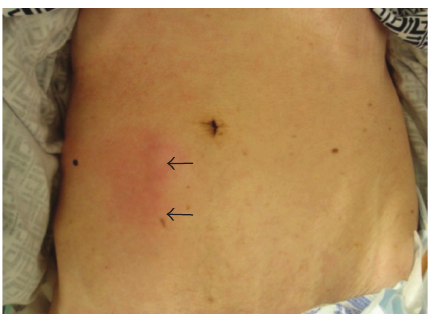
Figure 2: A photograph of the abdomen demonstrates subcuta- neous swelling in the right lower quadrant of the abdomen (see area adjacent to black arrows).